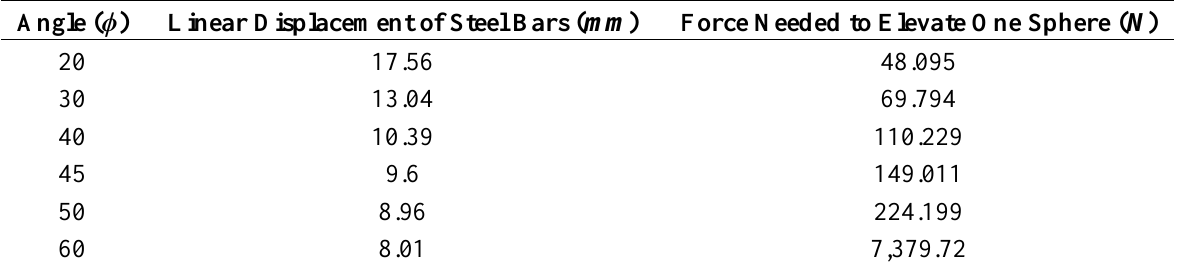
Table 1. Different angle ϕ values evaluated and their corresponding